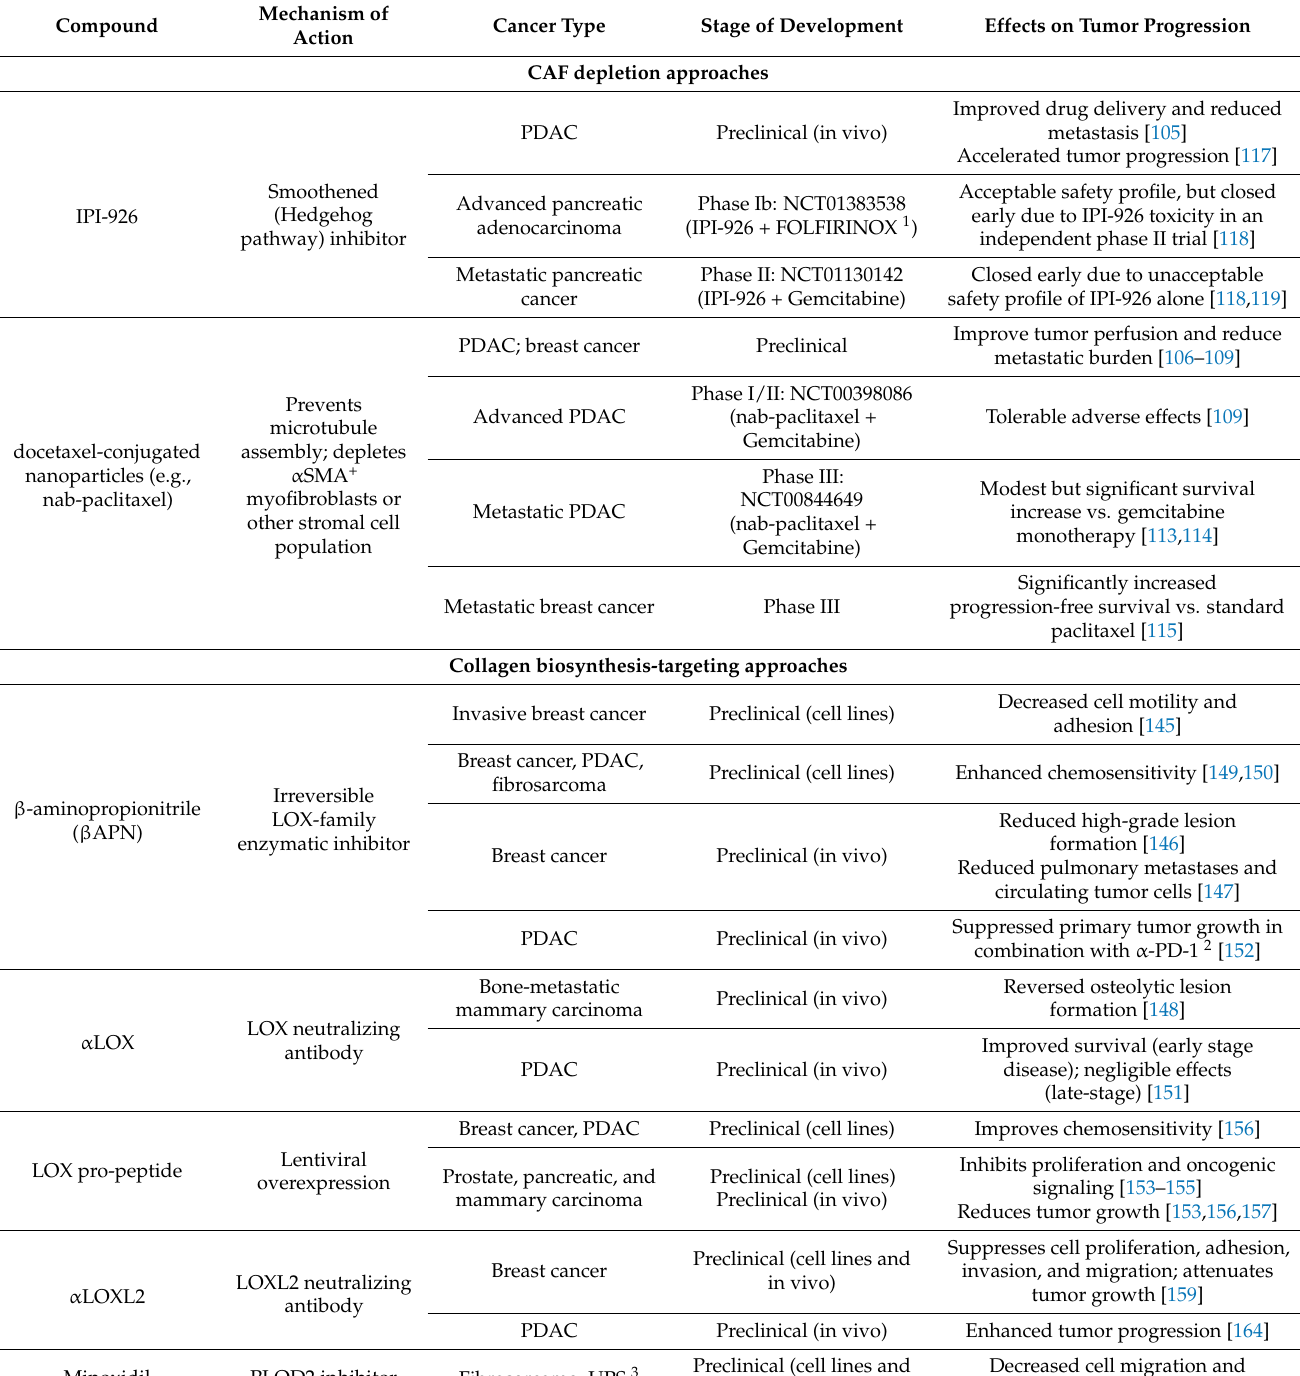
Table 2. Collagen-targeting approach clinical development